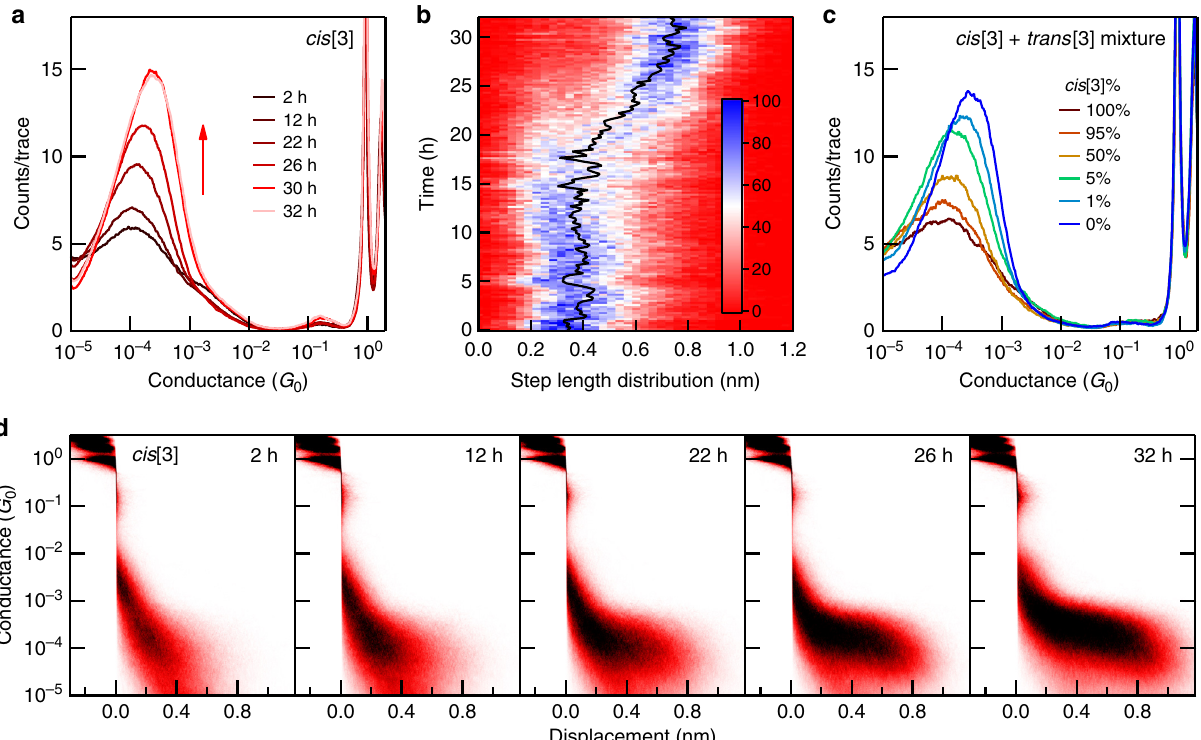
Fig. 2 Isomerization reactions of cumulenes observed during conductance measurements. a Logarithmically binned 1D histograms of 10,000 consecutive conductance traces measured at different times as indicated for cis[3] in tetradecane at a bias of 0.1 V. b Conductance step length distributions as a function of time showing a clear transition from a predominantly shorter plateau at the start of the experiment to longer ones at the end. The image includes step length analysis of 155,000 conductance traces in sets of 1000 traces. The step length is determined by counting data points in each trace over a conductance range between 10 − 3 and 10 − 4.9 G 0 . The black line traces the peak position. c Logarithmically binned 1D histograms for different mixtures of cis[3] and trans[3] in tetradecane measured at a 0.1 V bias. Each histogram is compiled from 5000 conductance traces. d 2D conductance- displacement histograms compiled from the same cis[3] data shown in